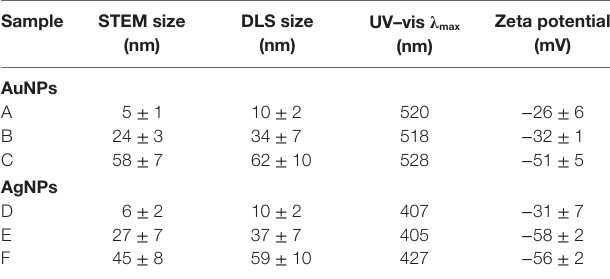
Table 3 | The overall results of AuNPs and AgNPs characterization.